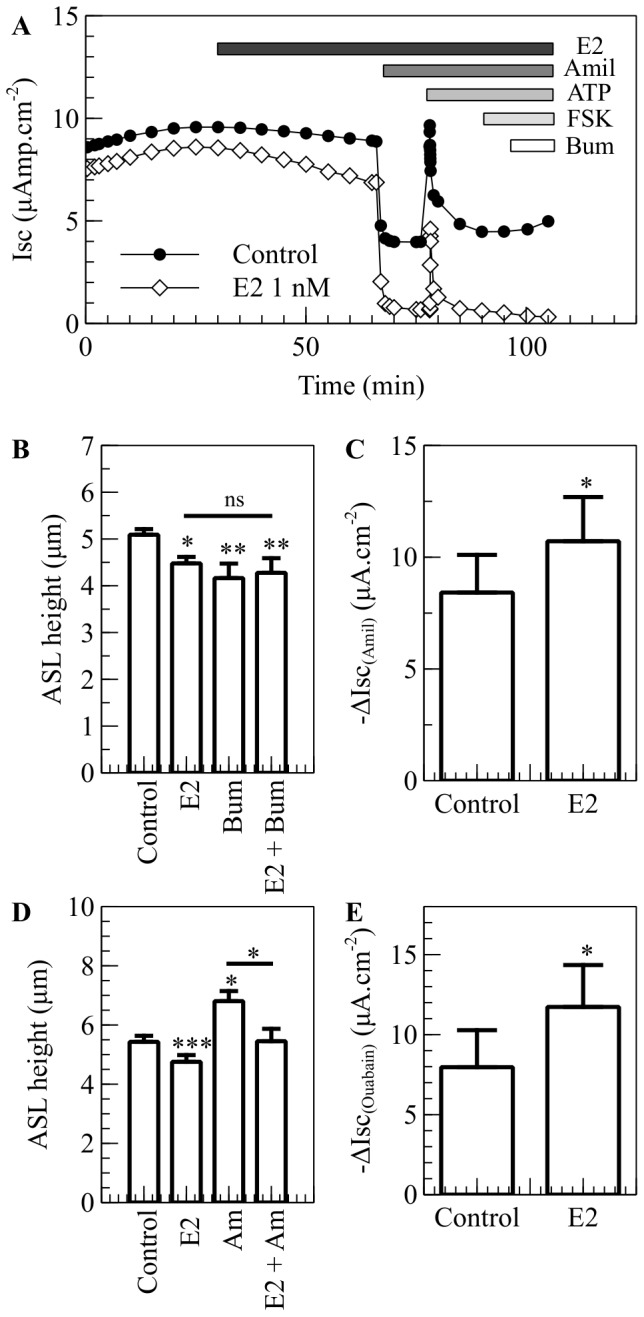
E2 increases Na+ absorption in CuFi-1 cells.CuFi-1 cells were cultured on collagen-coated culture inserts. The monolayers were allowed to reach a transepithelial resistance of 1,000 Ω.cm−2 or above prior the experiment. A. In the Ussing chambers, the cells were allowed to stabilize and were then treated basolaterally with E2. The changes in short-circuit current were measured in response to amiloride (10 µM), ATP (100 µM), forskolin (10 µM) and bumetanide (10 µM). Typical traces of Isc in vehicle and E2 treated CuFi-1 cells are shown. B. ASLh was measured in CuFi-1 cells in response to estrogen and NKCC1 inhibition. CuFi-1 monolayers were treated with E2 (1 nM), Bumetanide (Bum, 10 µM) or pretreated with estrogen before bumetanide was added (E2 + Bum) (n = 5, error bars reflect standard error of the mean, ANOVA, * p<0.05, ** p<0.01, ns: non significant). C. Amiloride-sensitive current in CuFi-1 cells treated with E2 or vehicle. Amiloride was added after 30 minutes (n = 6, Error bars reflect standard error of the mean, Student's t test, * p<0.05). D. ASLh measurement in CuFi-1 cells after treatment with E2 (30 min, 1 nM), Amiloride (Amil, 20 min, 300 µM) or pretreated with E2 and then treated with Amiloride (E2 + Amil) (n = 7, Error bars reflect standard error of the mean, ANOVA, * p<0.05, *** p<0.001). F. Ouabain–sensitive current in CuFi-1 cells mounted in Ussing chambers and bathed in modified low Na+ Krebs buffer in which NaCl was replaced by NMDG-Cl−. After the current stabilised, the apical membrane was permeabilized and the cells were treated with E2 or with vehicle and Ouabain (100 mM) was added to the basolateral chamber after 30 minutes (n = 4, Error bars reflect standard error of the mean, Student's t test, * p<0.05).